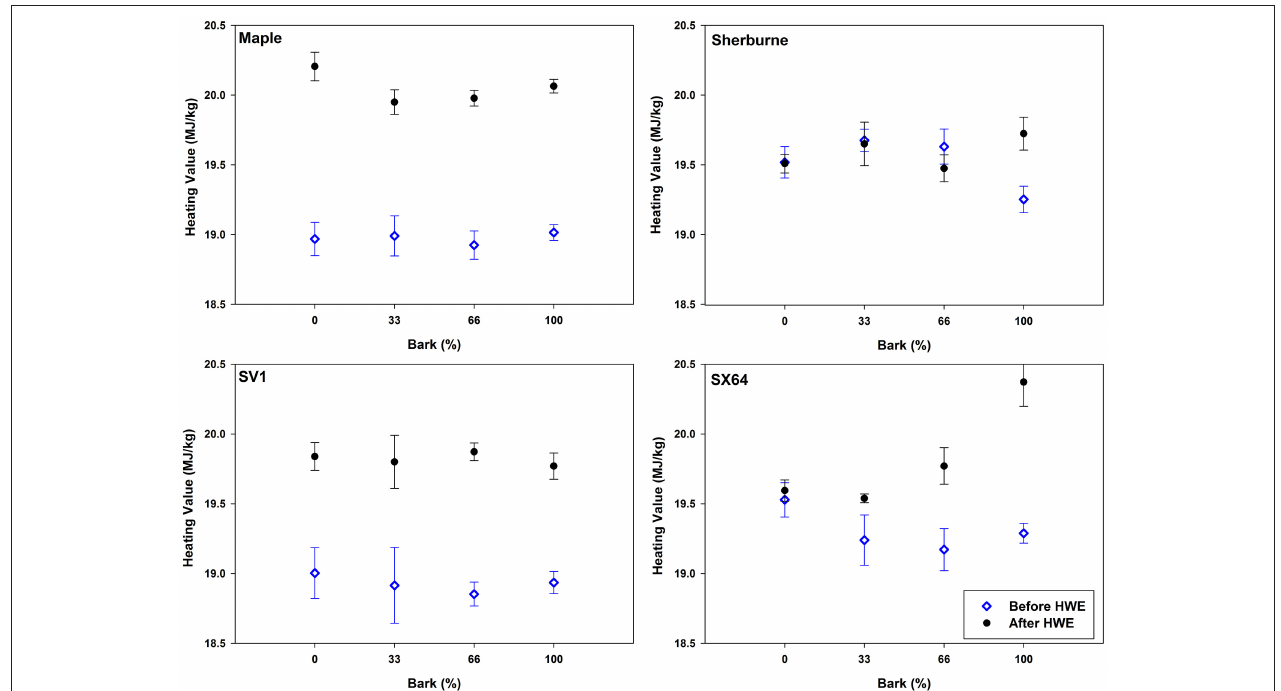
FIGURE 2 | Higher heating value of sugar maple and three willow cultivars with bark levels ranging from 0 to 100% before and after HWE (errors bars represent standard deviations).